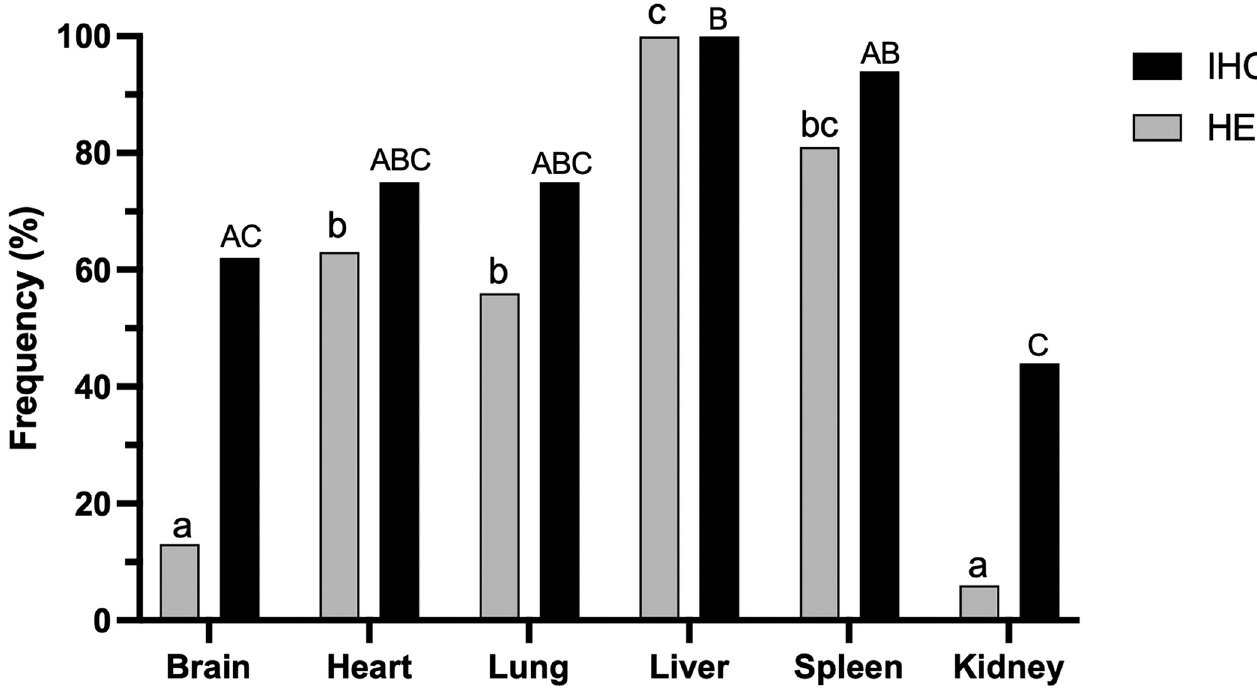
Fig 2. Frequency of intralesional Toxoplasma gondii zoites per organ (brain, heart, lung, liver, spleen, and kidney) evaluated by histopathology and immunohistochemistry. Fisher’s exact test was used to compare the distribution frequency of tachyzoites and bradyzoites in the different organs evaluated in HE stained sections (a,b,c: p < 0.05) or by IHC (A,B,C: p < 0.05).